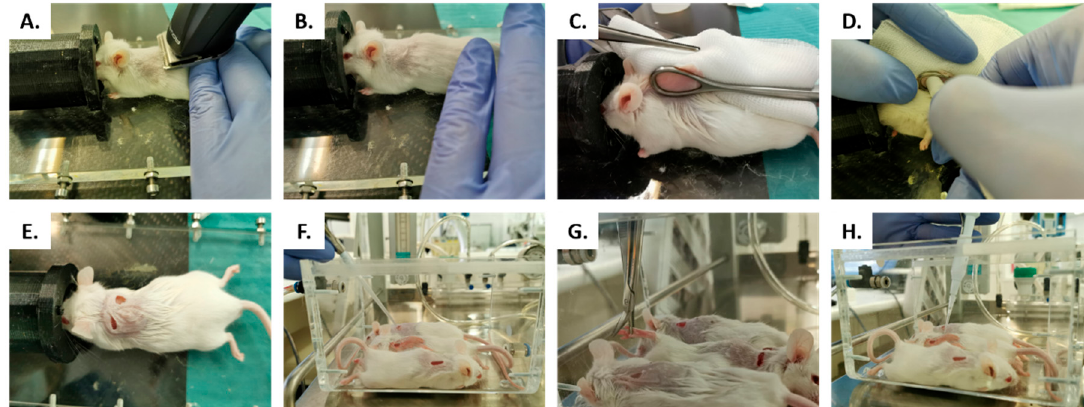
Figure 11. In vivo wound model, the interscapular skin was completely shaved ( A ) and disinfected with 70% ethanol ( B ). Two 5-mm full-thickness excisional wounds were created using a non-toothed Foerster caliper ( C ) and a 5-mm biopsy punch ( D , E ). The wounds of untreated group were compared to groups treated with: Sanguiin H-6 or lambertianin C ( F ). During this preventive treatment, we cut the nails of hind legs ( G ). After treatment, each wound was infected with SAP231 MRSA strain ( H